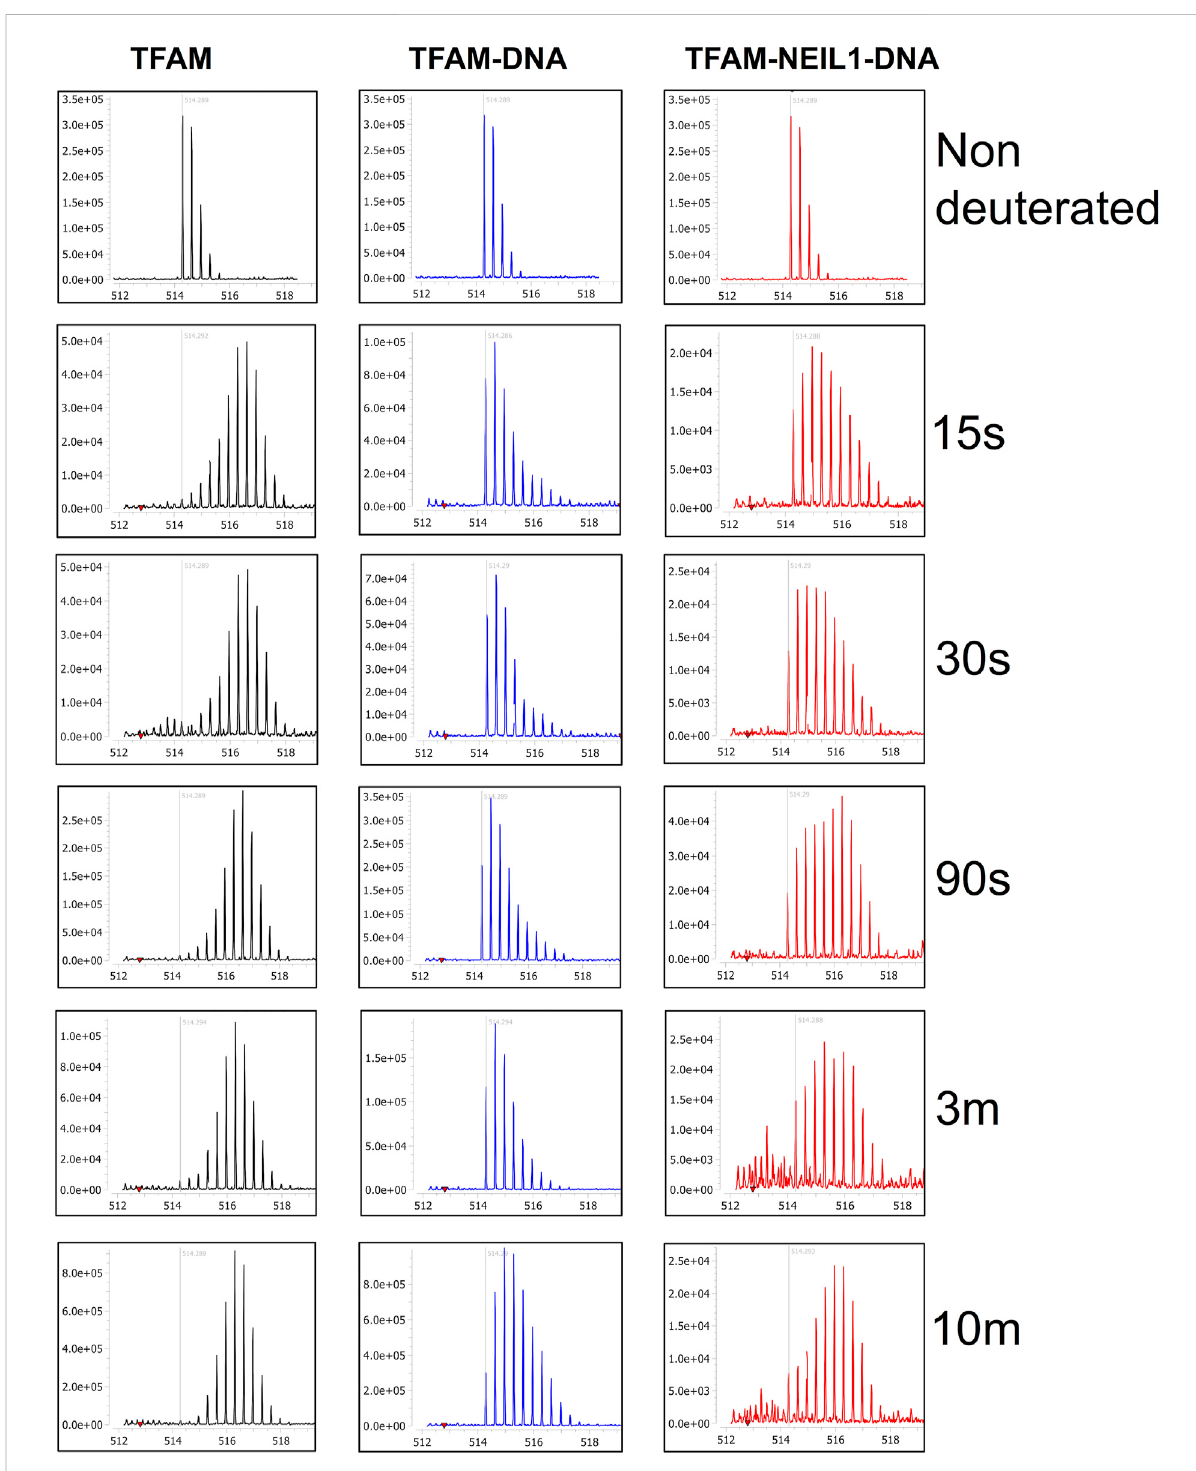
FIGURE 9 Isotopic mass distribution spectra reveal bimodal deuterium exchange upon the addition of NEIL1 to the TFAM-DNA complex. Isotopic mass distribution spectra from representative HDX-MS experiments for the peptide containing TFAM residues 57 – 68 at various time points as indicated (15 s – 10 m).ThedistributionpatternforTFAMalone(black)displaysgreaterdeuteriumexchangewhencomparedtotheTFAM-DNAcomplex(blue), which appears to exchange less deuterium. The addition of NEIL1 to the sample mixture (TFAM-NEIL1-DNA complex; red) reveals a bimodal isotopic mass distribution, which likely results from the presence of multiple species (protein-protein; protein-DNA; protein-protein-DNA; or protein alone) within the sample. The grey line within each plot indicates an m/z value of 514.29 corresponding to the non-deuterated peptide.